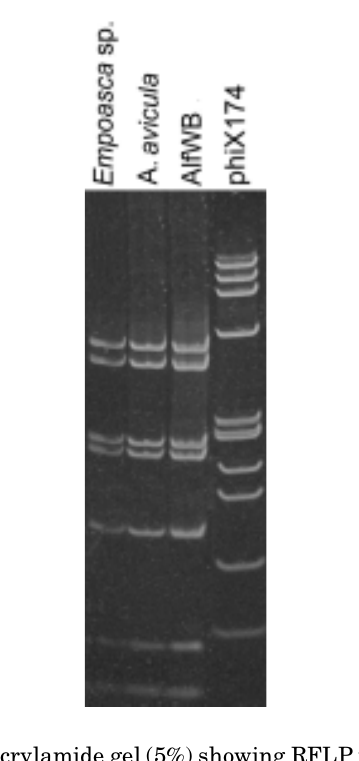
Fig. 3. Polyacrylamide gel (5%) showing RFLP patterns of phytoplasmas detected in A. avicula , Empoasca sp. and OmanAlfWB phytoplasmas of the 16S plus spacer region DNA fragments amplified with P1/P7 primers analyzed with Taq I restriction enzyme. Markers and abbreviations are as in Fig.